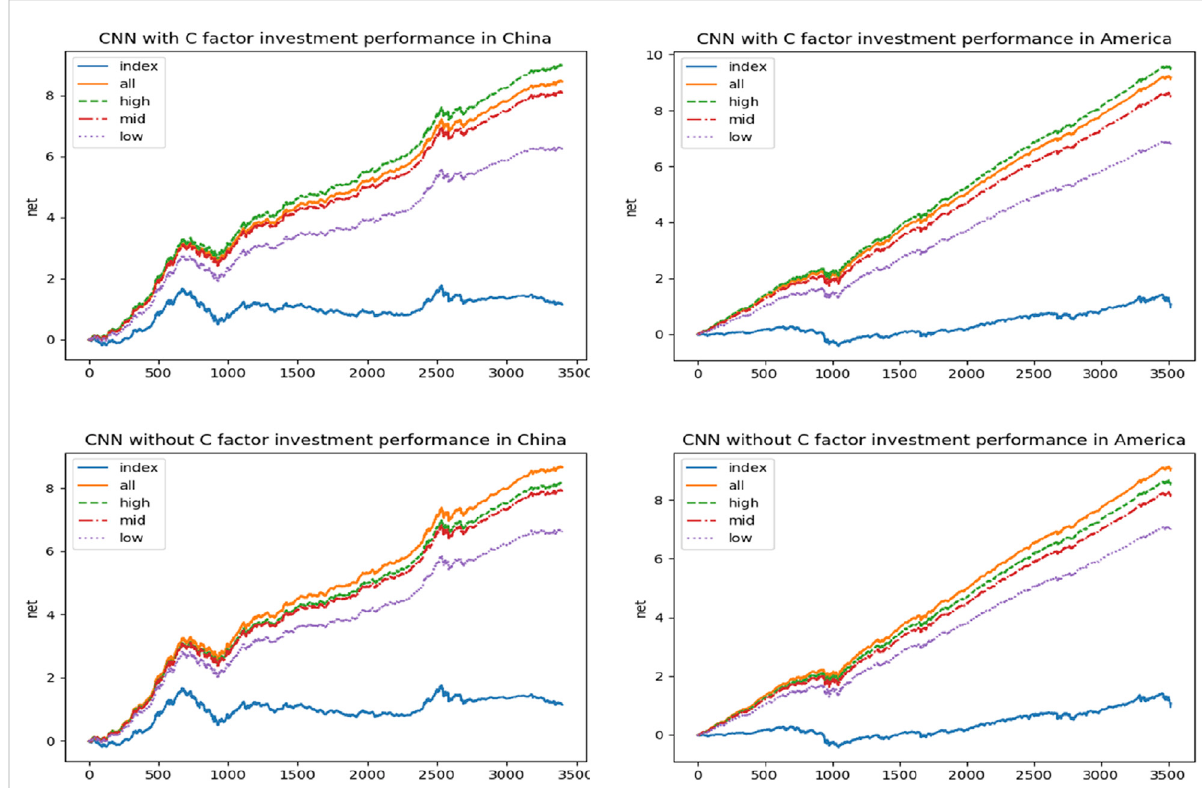
FIGURE 4 Cumulative return rate of portfolio constructed by Multi-CNN method. Note: the fi gure shows the cumulative returns from January 2005 to December 2018 of investment portfolios constructed by China and America through Multi-CNN method with and without carbon factors in feature engineering.SSEComposite IndexisselectedasbenchmarkinChina,while theS&P500isselectedinAmerica.Inthelegend,allstandsforallstocks, high stands for high-carbon industry, mid stands for medium-carbon industry and low stands for low-carbon